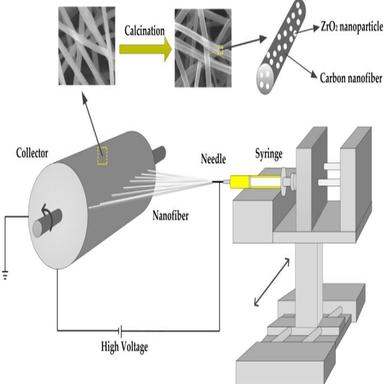
Schematic illustration of the synthesis of ZrO2/CNF by electrospinning technique.